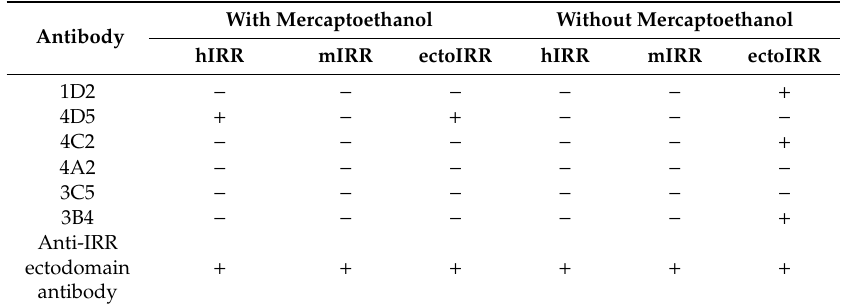
Western blotting of human insulin receptor-related receptor (hIRR), mouse insulin receptor-related receptor (mIRR), and hIRR ectodomain with monoclonal antibodies. With Mercaptoethanol Without Mercaptoethanol Antibody hIRR mIRR